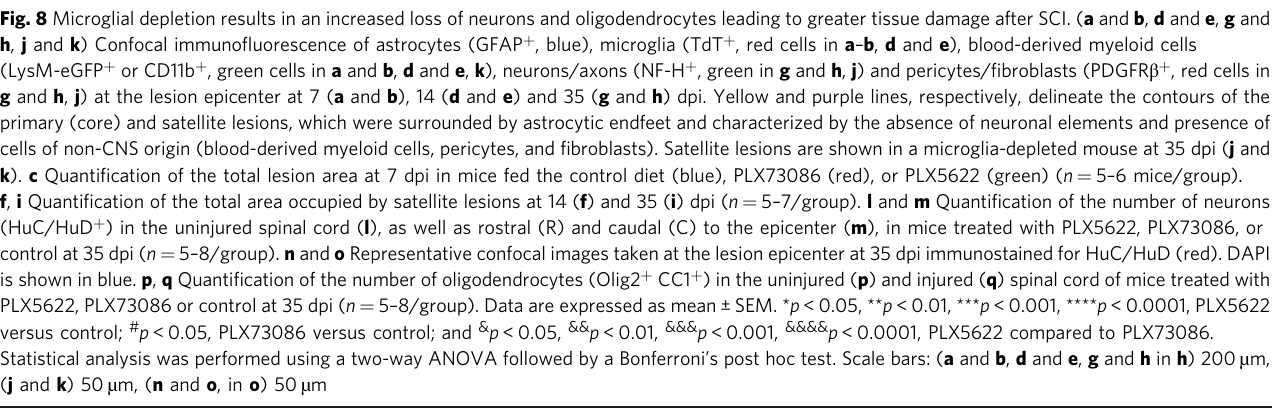
Fig. 8 Microglial depletion results in an increased loss of neurons and oligodendrocytes leading to greater tissue damage after SCI. ( a and b , d and e , g and h , j and k ) Confocal immuno fl uorescence of astrocytes (GFAP + , blue), microglia (TdT + , red cells in a – b , d and e ), blood-derived myeloid cells (LysM-eGFP + or CD11b + , green cells in a and b , d and e , k ), neurons/axons (NF-H + , green in g and h , j ) and pericytes/ fi broblasts (PDGFR β + , red cells in g and h , j ) at the lesion epicenter at 7 ( a and b ), 14 ( d and e ) and 35 ( g and h ) dpi. Yellow and purple lines, respectively, delineate the contours of the primary (core) and satellite lesions, which were surrounded by astrocytic endfeet and characterized by the absence of neuronal elements and presence of cells of non-CNS origin (blood-derived myeloid cells, pericytes, and fi broblasts). Satellite lesions are shown in a microglia-depleted mouse at 35 dpi ( j and k ). c Quanti fi cation of the total lesion area at 7 dpi in mice fed the control diet (blue), PLX73086 (red), or PLX5622 (green) ( n = 5 – 6